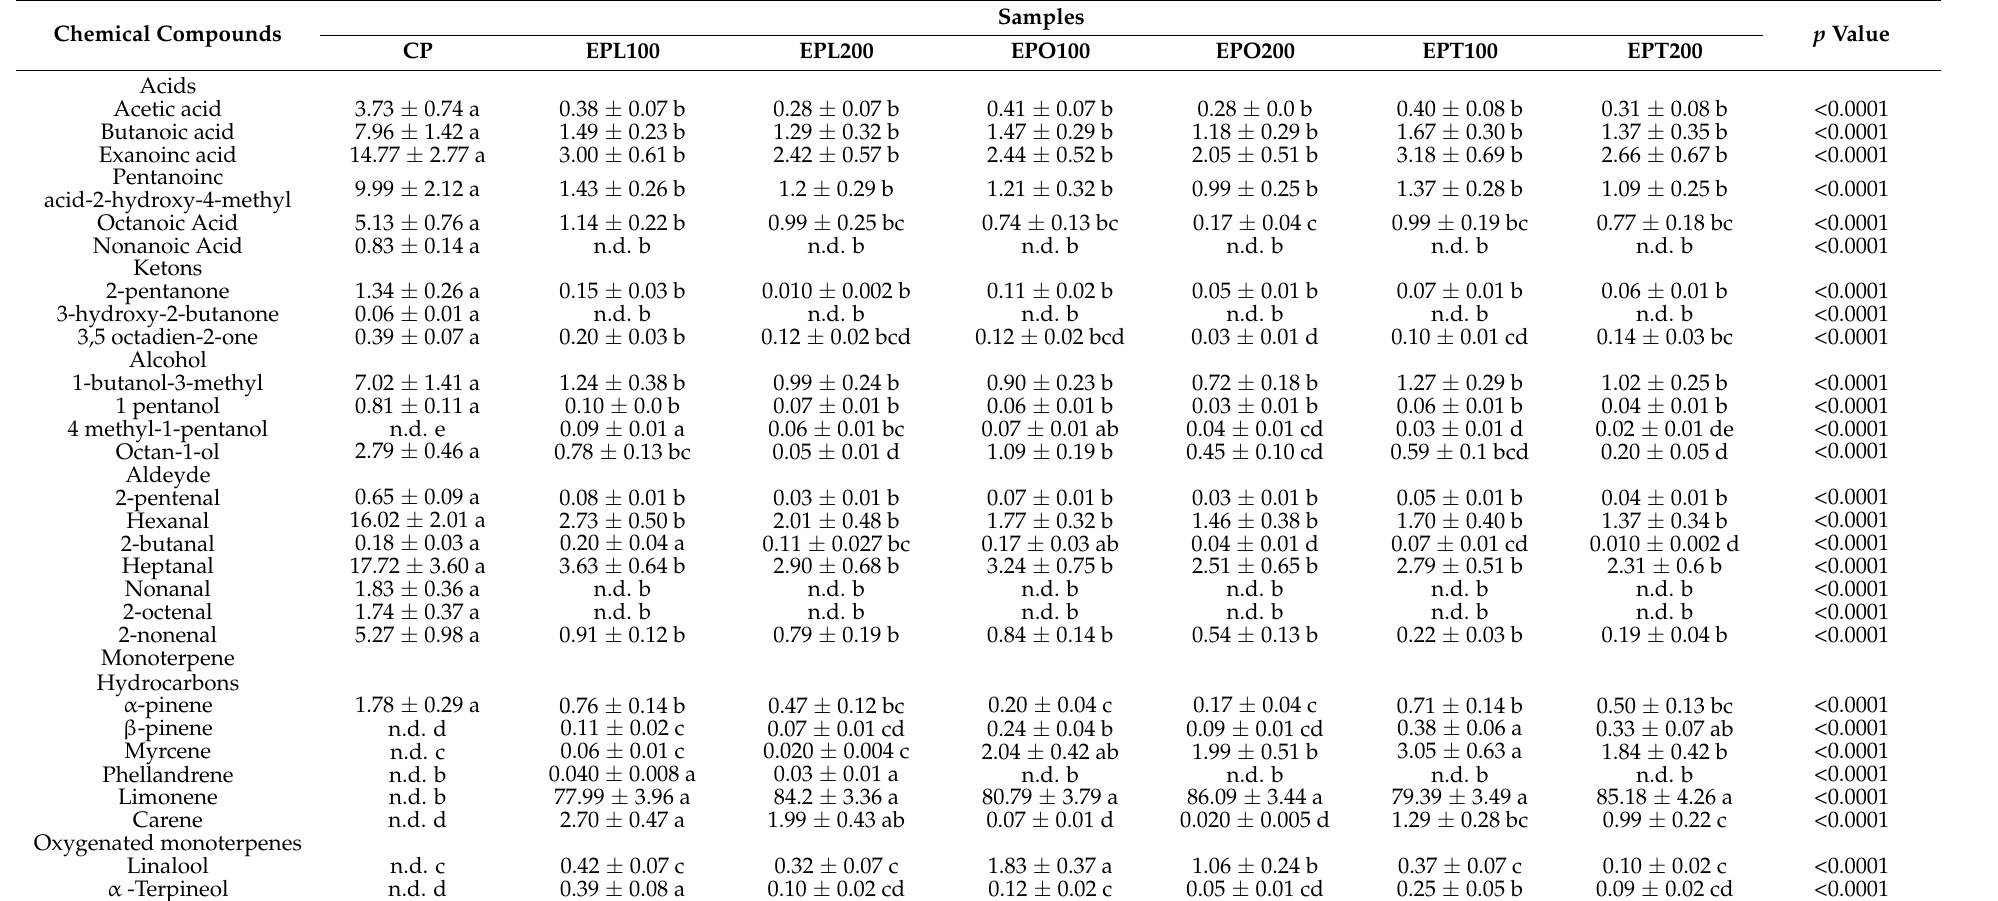
Table 5. Volatile organic compounds emitted Primosale